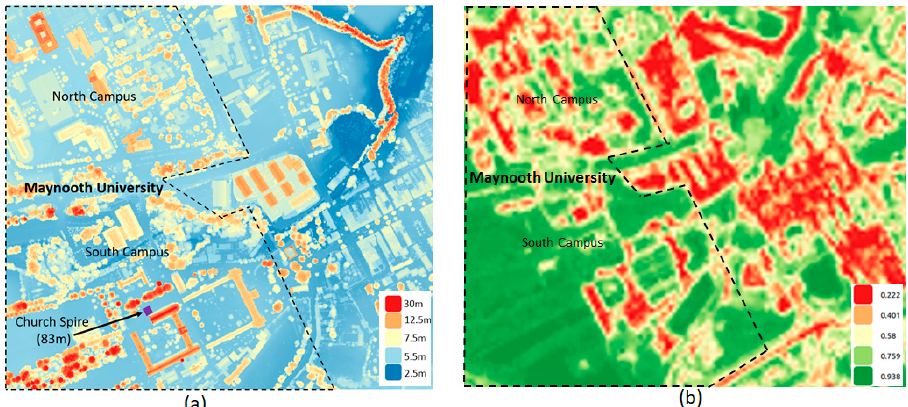
Figure 5. ( a ) 1 m resampled Digital Elevation Model (DEM) of Maynooth University town; ( b ) Normalised Distribution Vegetation Index (NDVI) over Maynooth from Sentinel-2 with vegetated areas in shades of green and the built-environment represented in shades of yellow, orange and red.